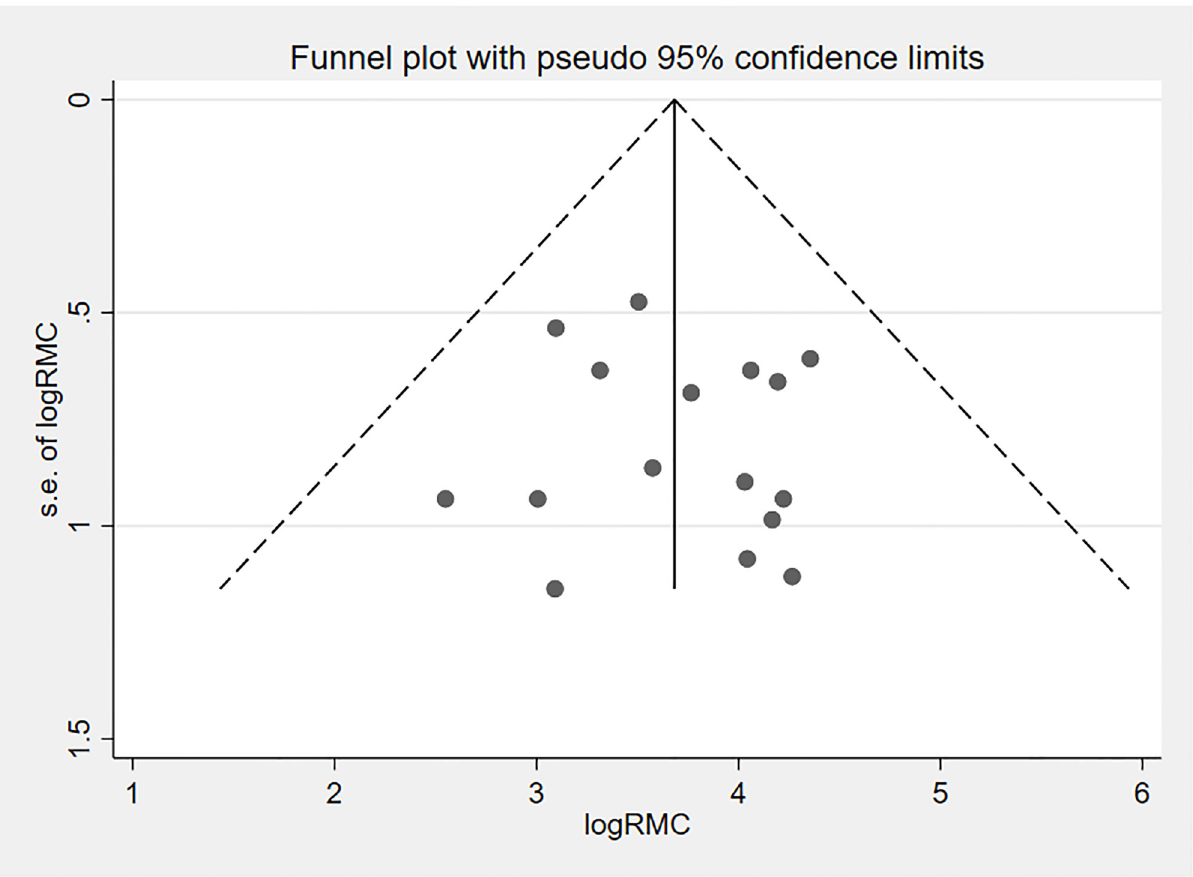
Fig 5. Funnel plot displaying publication bias of studies reporting the RMC in Ethiopia,